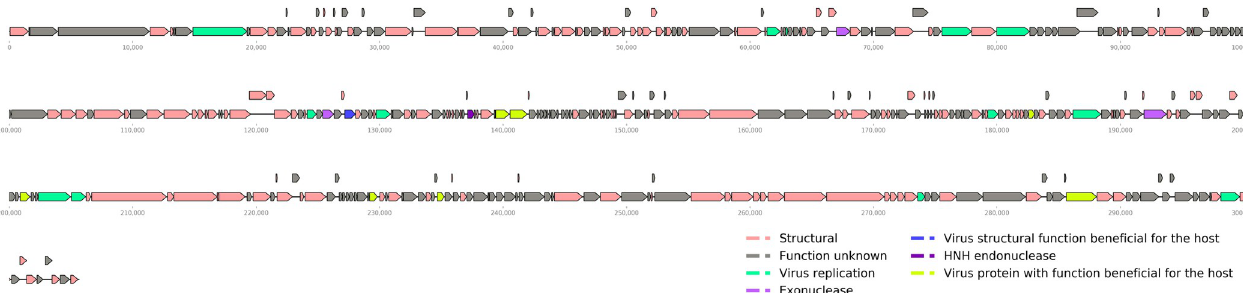
Fig 2. LucasX genome. The annotation was performed by HMM searches using the Viral Ortholog Groups (VOGs) database and the tool DeepCapTail. The figure was produced using the Python library DNAFeaturesViewer .